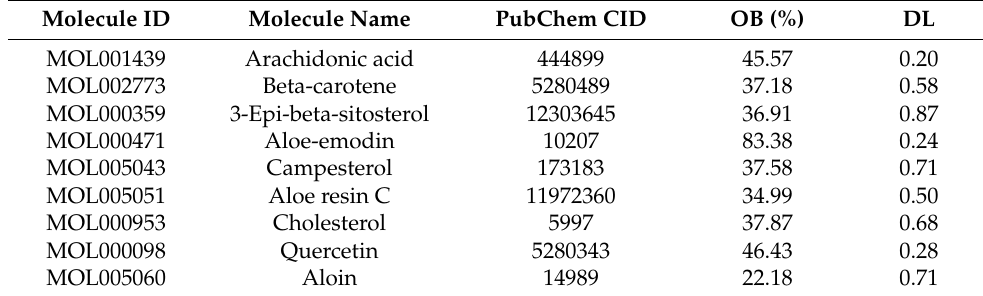
Table 1. Active ingredients of Aloe vera